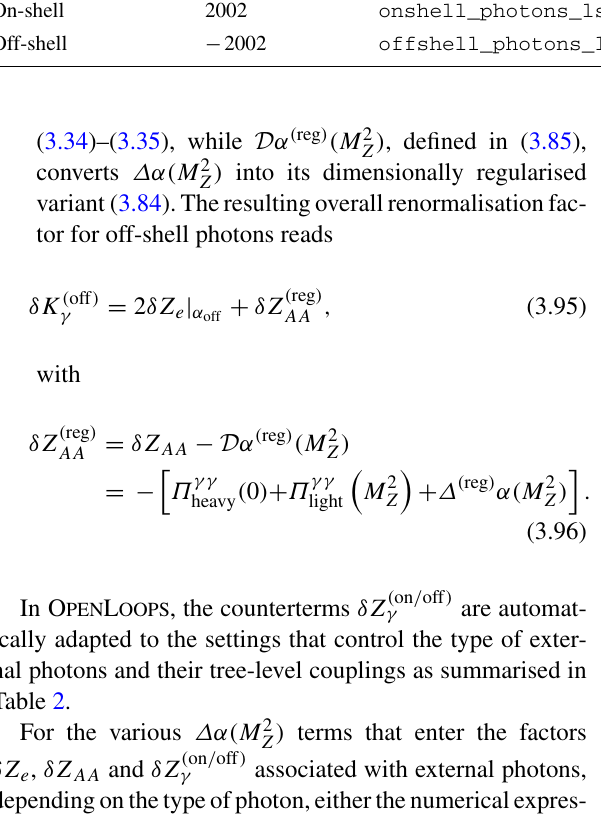
Table 2 PDG identifiers for photons and switchers that control the coupling factors and renormalisation constants for the different types of external photons introduced in Sect. 3.2. The high-energy coupling α off is defined in (3.34). If the switchers are set to zero (default